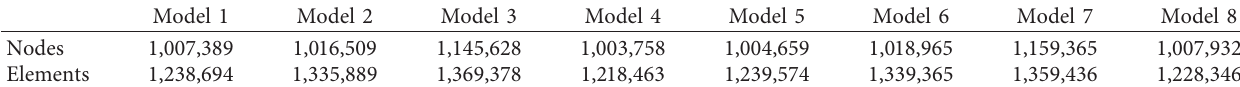
Table 2: The values of nodes and elements of all